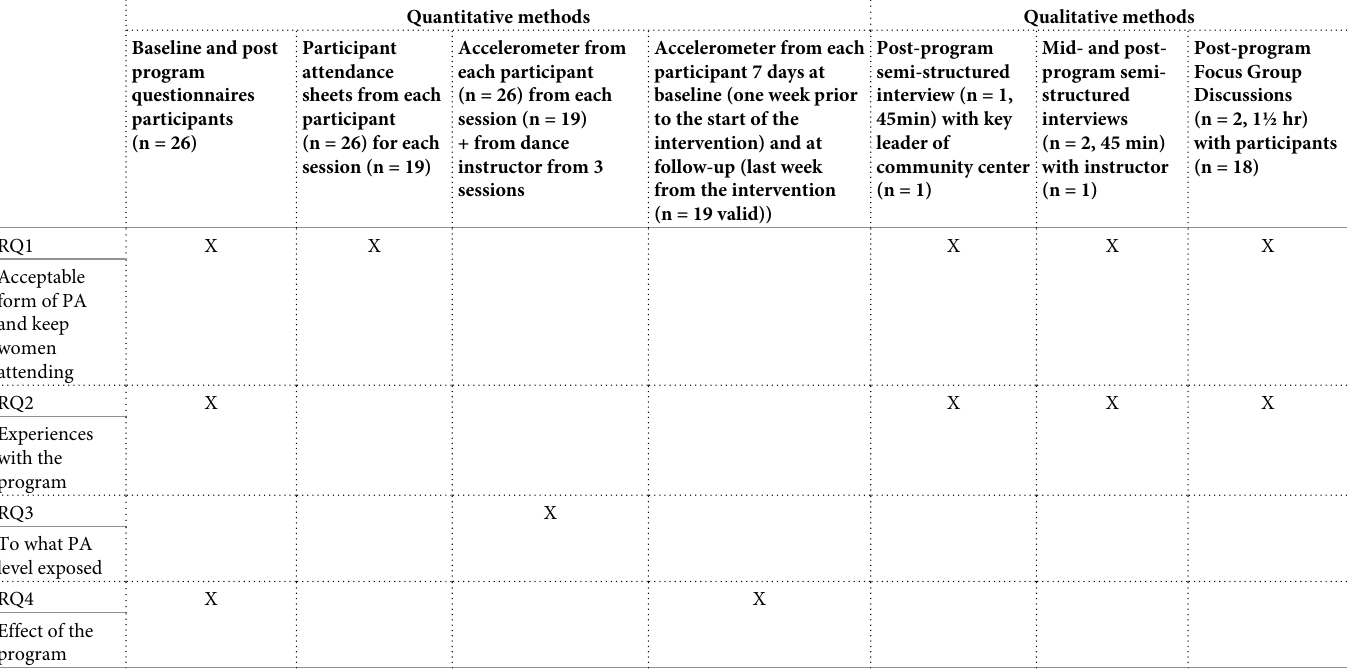
Table 1. Data collection method for each research question